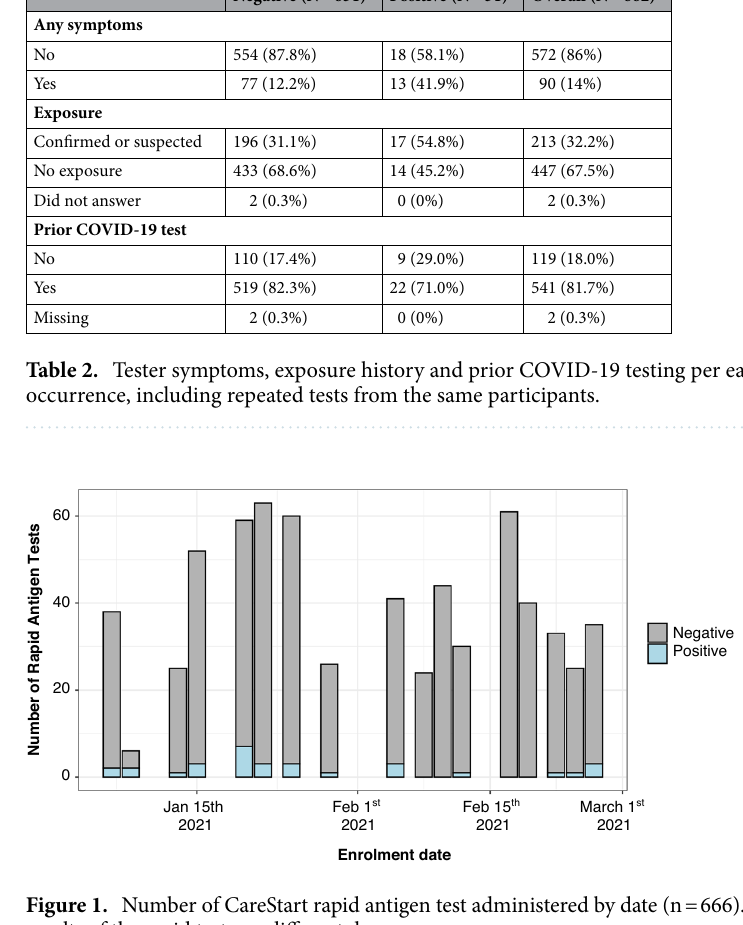
Figure 1. Number of CareStart rapid antigen test administered by date (n = 666). The bar colors reflect the results of the rapid tests on different